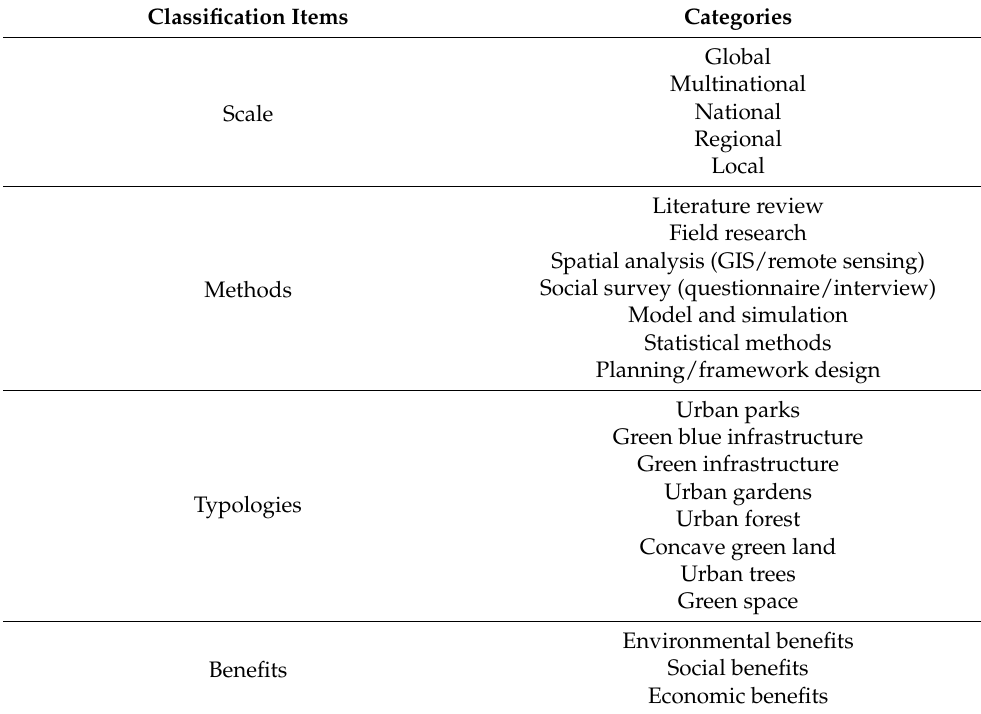
Table 1. Categories and themes that were defined for analyzing the selected UF-NBS